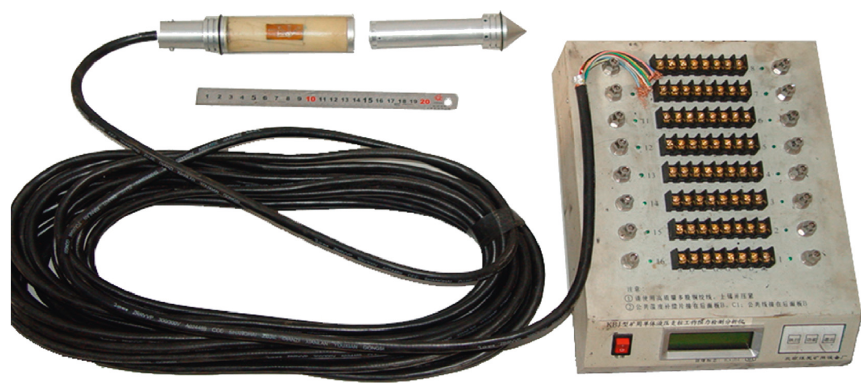
Figure 6: KJ327-F type borehole strainmeter.